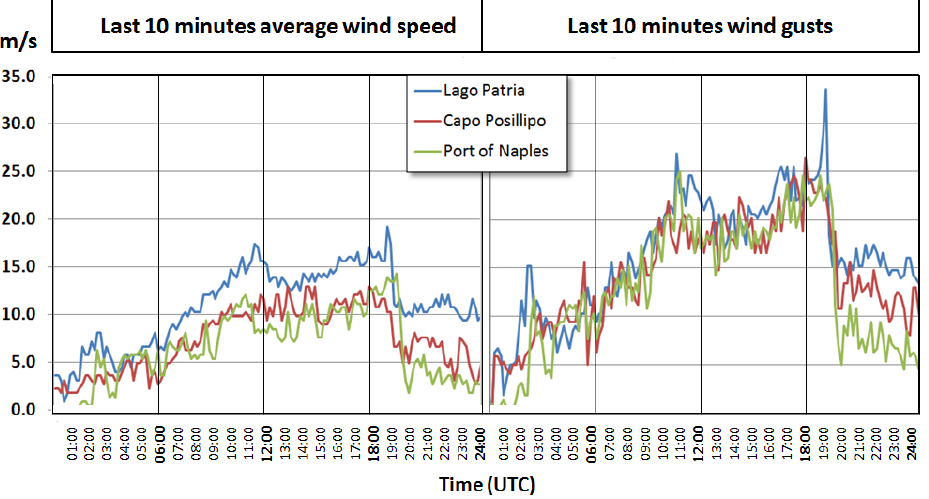
Figure 8. Lago Patria, Capo Posillipo, and Port of Naples ISMAR weather stations wind